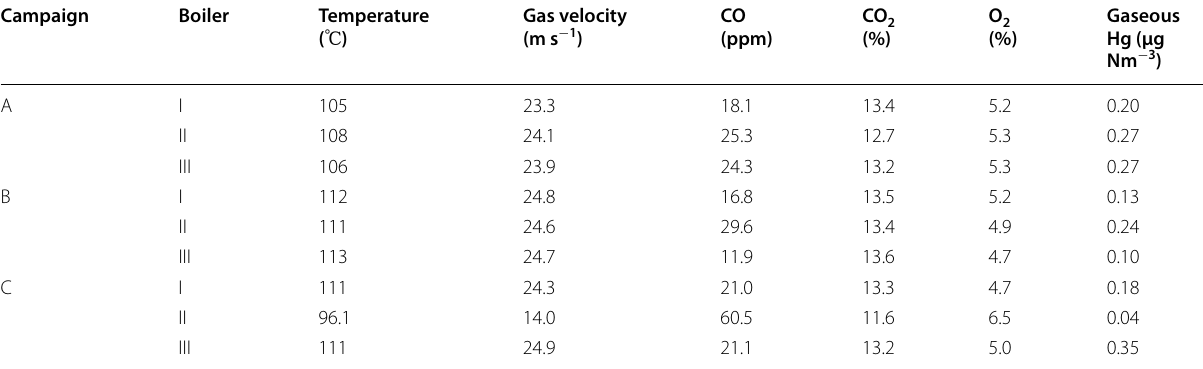
Table 2 Important parameters of stack gas in coal-fired power plant investigated Campaign